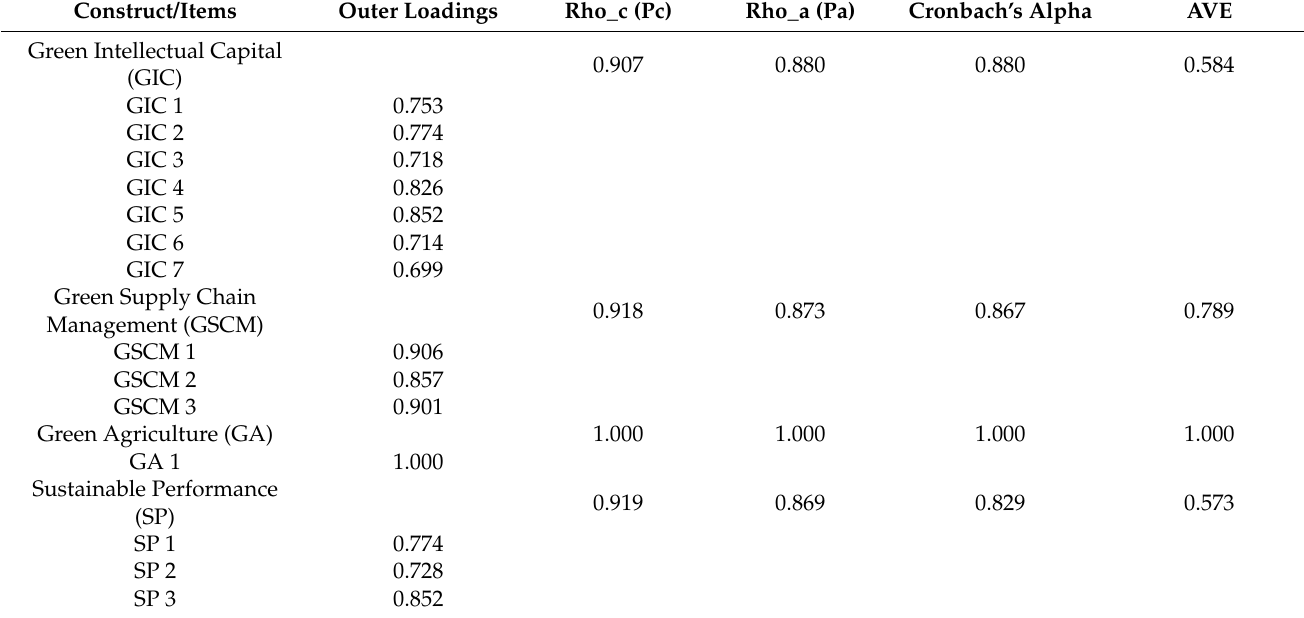
Table 3. Measurement model analysis: external loadings, construct reliability and convergent validity.